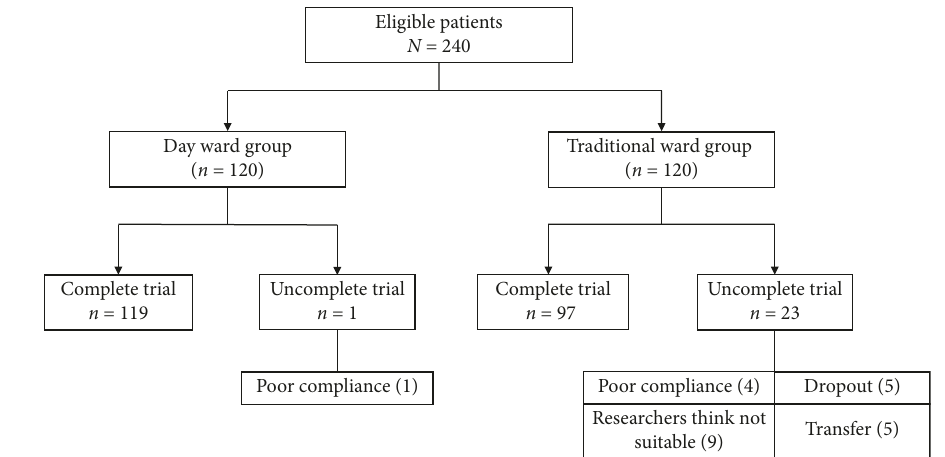
Figure 2: Patients followed throughout the Table 1: Demographic features and clinical characteristics of all participants.